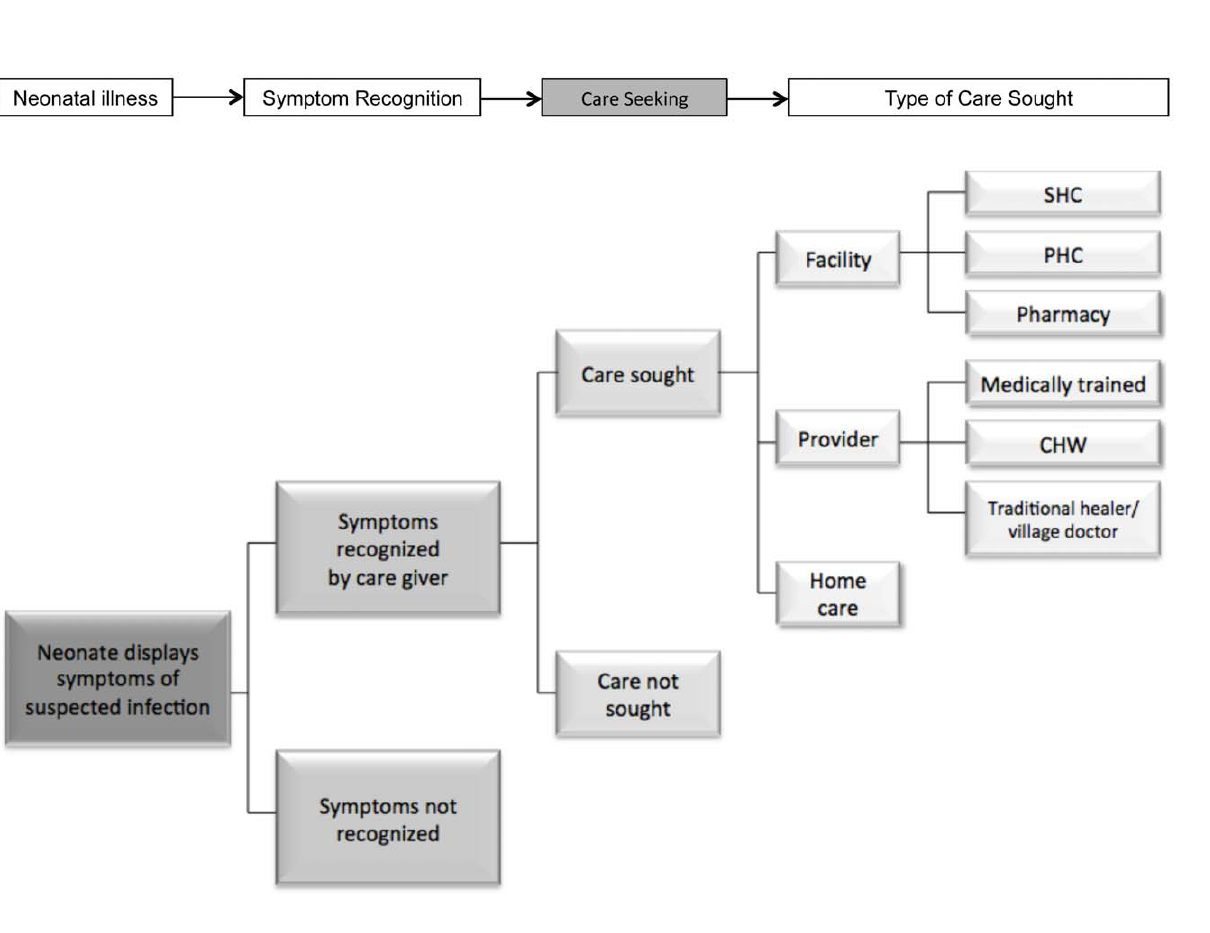
Figure 2. Defining care seeking conceptually. CHW, community health worker; PHC, primary health care; SHC, secondary health care.